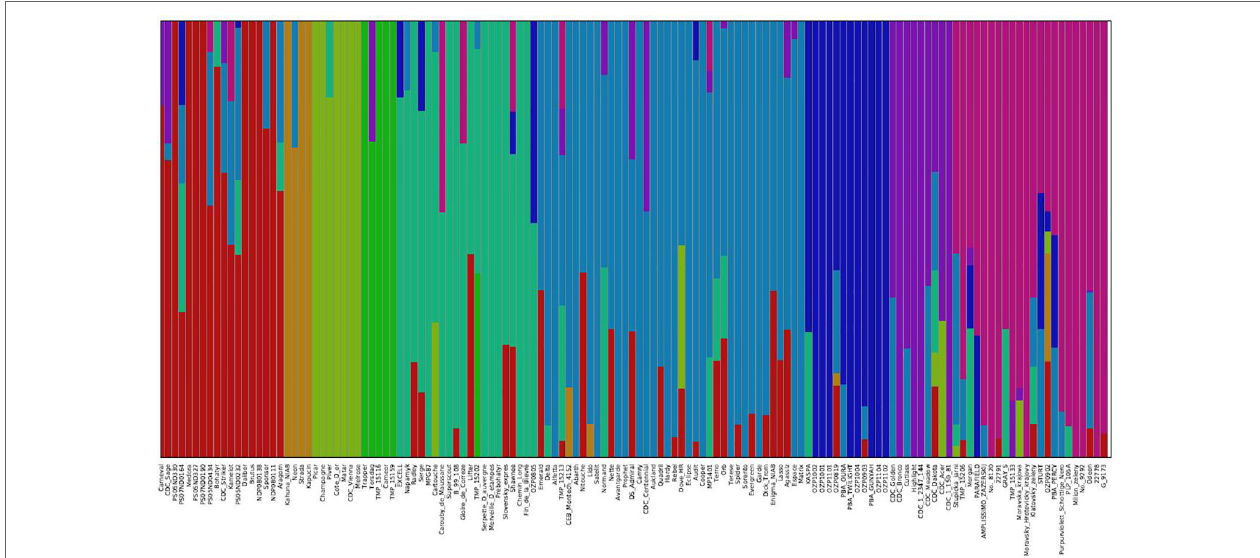
FiGUre 3 | Population structure of 135 pea accessions based on K = 9. In the panel, each accession is indicated as a vertical bar partitioned into colored segments where the respective length of these segments represents the proportion of the individual's genome in a given group.